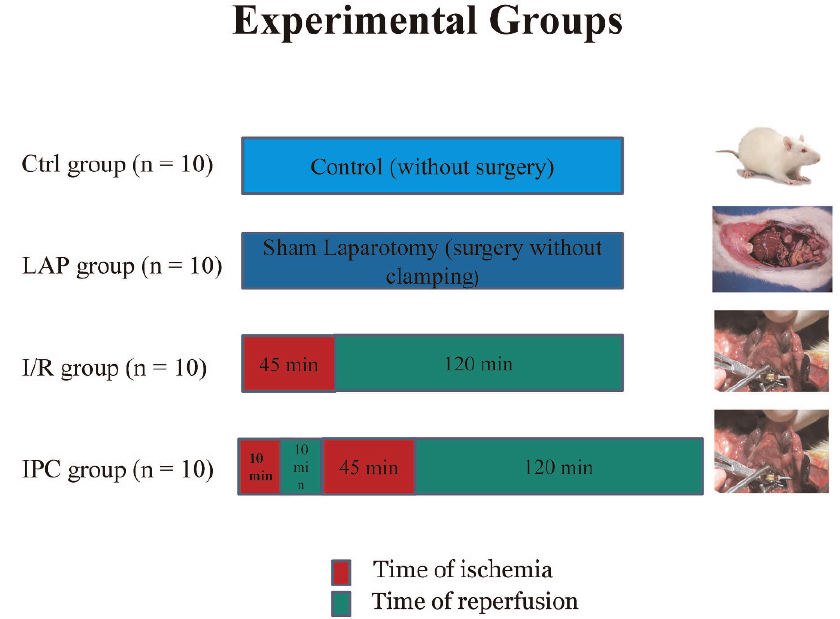
Figure 1 - Experimental groups and their times of ischemia and reperfusion, where n represents the number of animals per